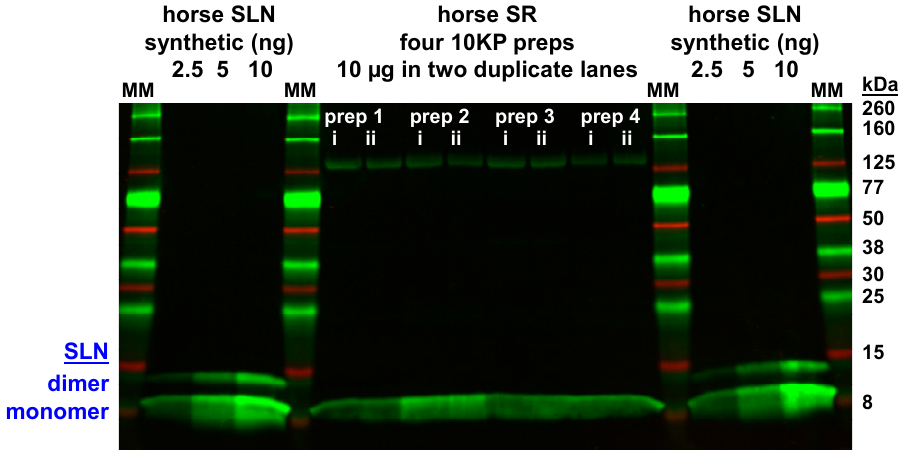
Figure 2. Immunoblot analysis using custom anti-horse-SLN pAb GS3379 detects minimal expression of SLN protein in horse SR vesicles. The primary antibody was the custom anti-horse-SLN pAb GS3379, with immunogen comprising horse residues 1 MEWRRE 6 . Samples were electrophoresed through a 4–20% Laemmli gel. Horse SR vesicles were assayed (N = 4 preps; 10 µ g protein per lane; each prep run in duplicate lanes). Synthetic horse SLN was used as a quantitative standard (2.5, 5, or 10 ng / lane) in duplicate sets on left and right sides on the gel. Immunoblotting was performed using pAb GS3379 (primary) and goat anti-rabbit-IgG pAb labeled with 800-nm fluorophore (secondary). Immunolabeling was quantified using the LI-COR laser scanner system. Protein gel markers (kDa) are indicated on the right. Two putative molecular species of SLN on SDS-PAGE (monomer and dimer) are indicated by blue text on the left.